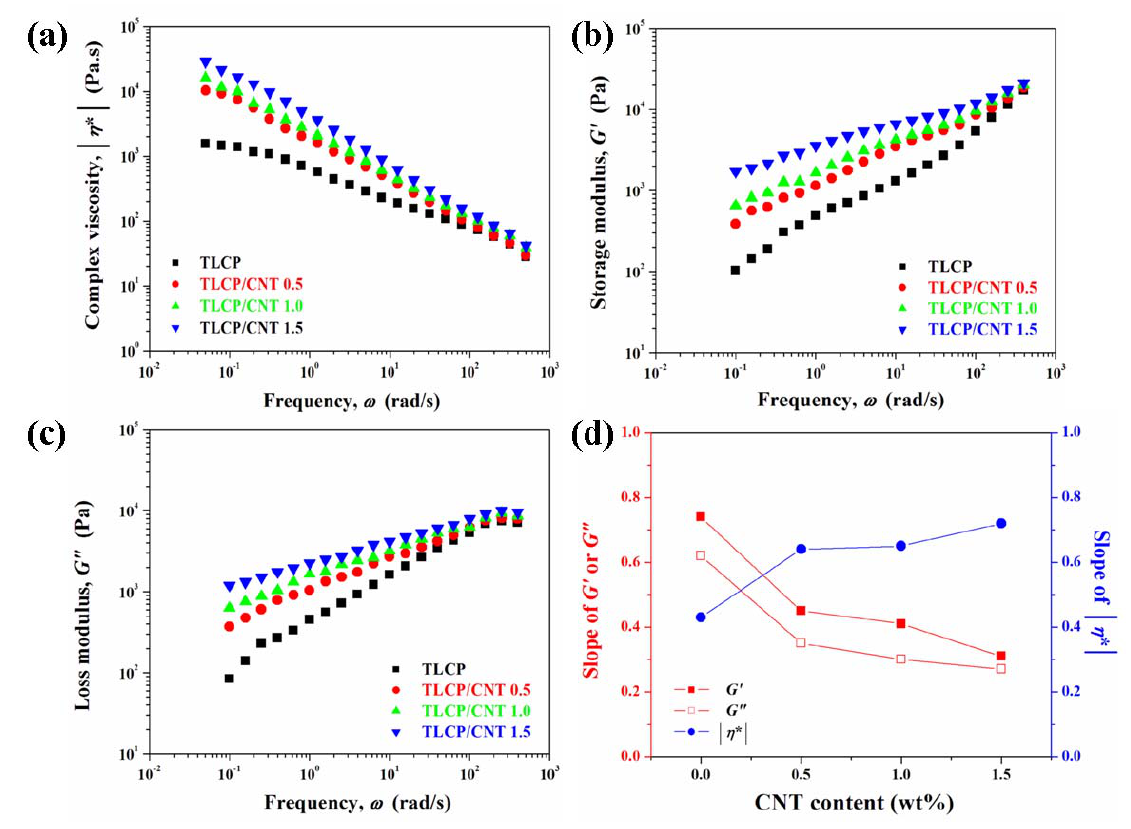
Figure 4. Rheological properties of TLCP nanocomposites. (a) Complex viscosity ( |η * | ), (b) storage modulus ( G ′ ), and (c) loss modulus ( G ″ ) of TLCP nanocomposites as a function of applied frequency. Reproduced with permission from Ref. [43]. © 2008 Elsevier Ltd. (d) Variations of slopes of G ′ , G ″ , and |η * | versus ω for TLCP nanocomposites with CNT content. Data from Ref.